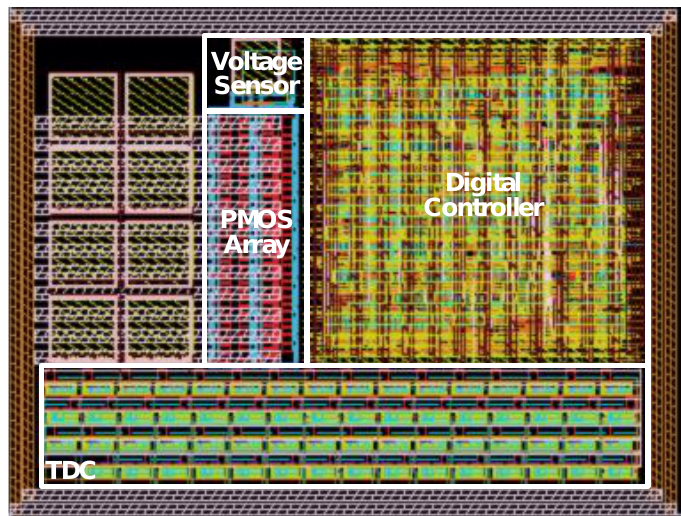
Figure 8. The layout of the proposed